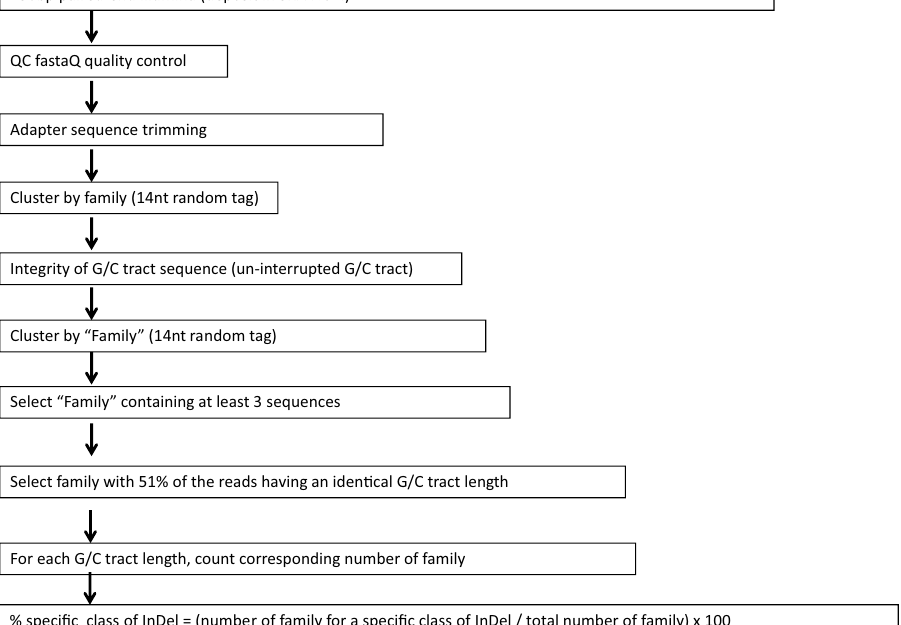
Figure 5. MDS bioinformatic workflow. Selection and clustering of the “family” sequences containing a specific G/C tract specified at bbr_0113 and bbr_1889 chromosomal